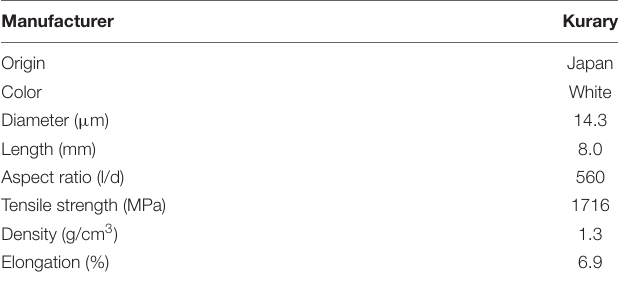
TABLE 2 | Physical properties of polyvinyl alcohol (PVA)